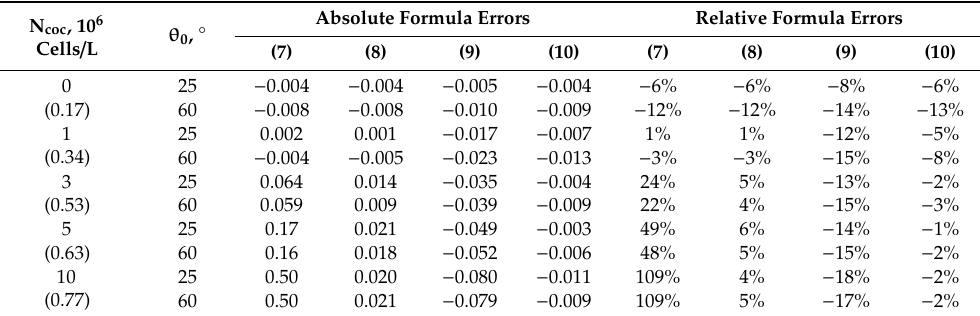
Table 7. Absolute and relative errors of Equations (7–10), depending on the N coc value and the solar zenith angle for the Black Sea, λ = 490 nm and a (440) = 0.09 m − 1 . The value of parameter u is shown in the first column in